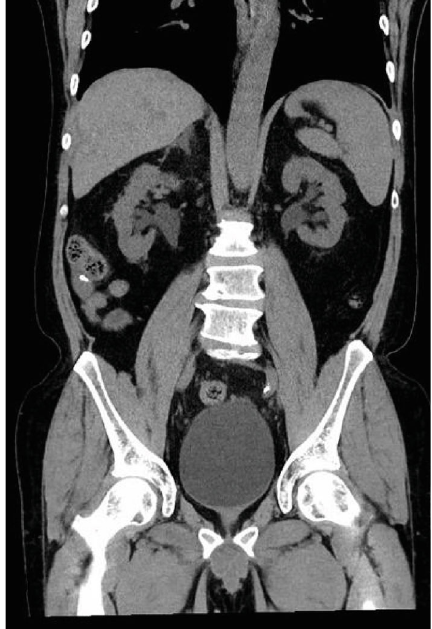
Figure 2: Noncontrast CT abdomen in coronal plane showing bilateral hydronephrosis.